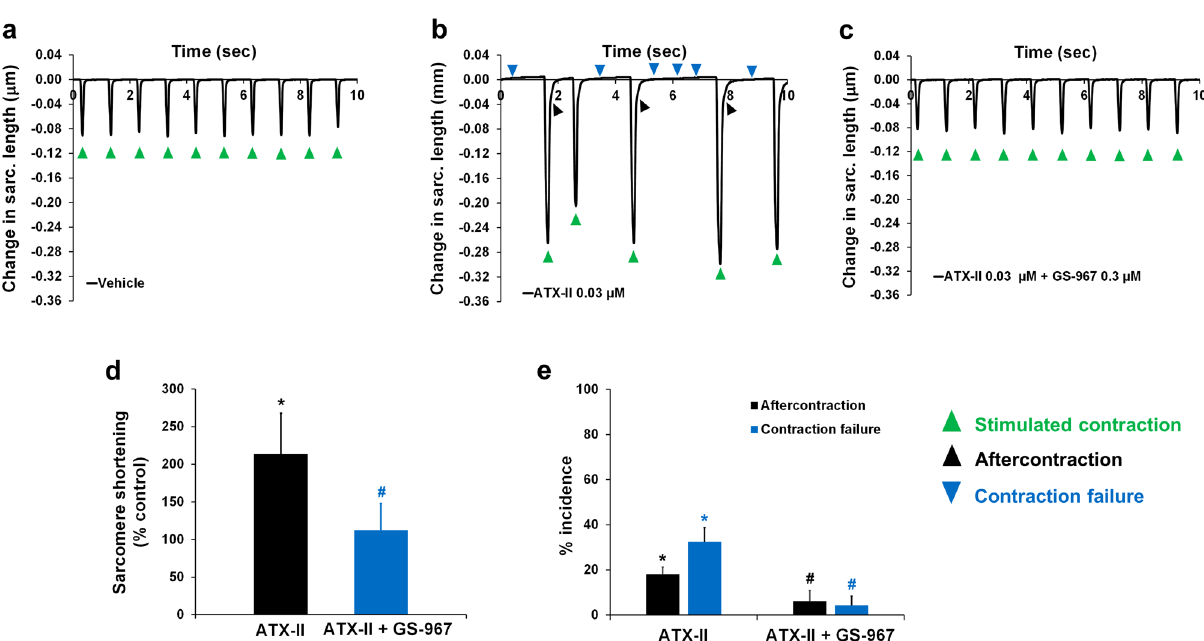
Figure 9. Effects of GS-967 on human atrial contractility in condition mimicking LQTS3. ( a – c ) show typical contractility transients recorded from a ventricular cell at a pacing of 1 Hz in the presence of vehicle control ( a ) and after exposure to 0.03 µM ATX-II alone ( b ) or in combination with 0.3 µM GS-967 ( c ). ( d ) and ( e ) show mean % change in sarcomere shortening ( d ) and mean % incidence of aftercontraction and contraction failure ( e ) when cardiomyocytes were treated with 0.03 µM ATX-II alone or in combination with 0.3 µM GS-967 (n = 5 cells) at 1 Hz. *,* p < 0.05 versus values from vehicle control. #,# p < 0.05 versus values from ATX-II. IonWizard software (v1.2.22, IonOptix LLC, MA, USA, www. ionop tix. com) was used to generate the representative contractility